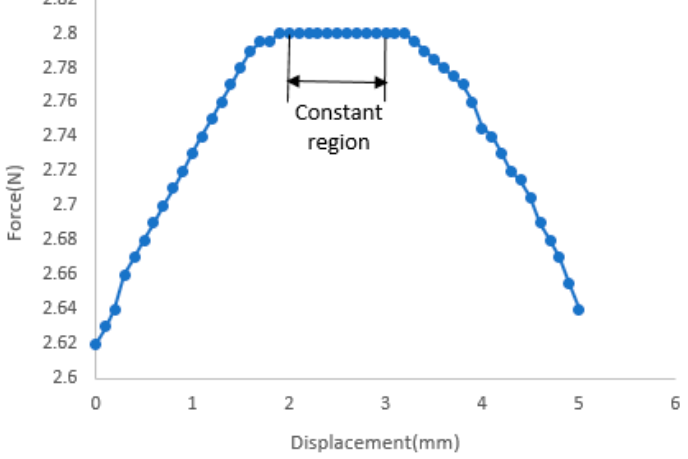
Figure 10. Variation of force (F) according to bobbin displacement from the center.